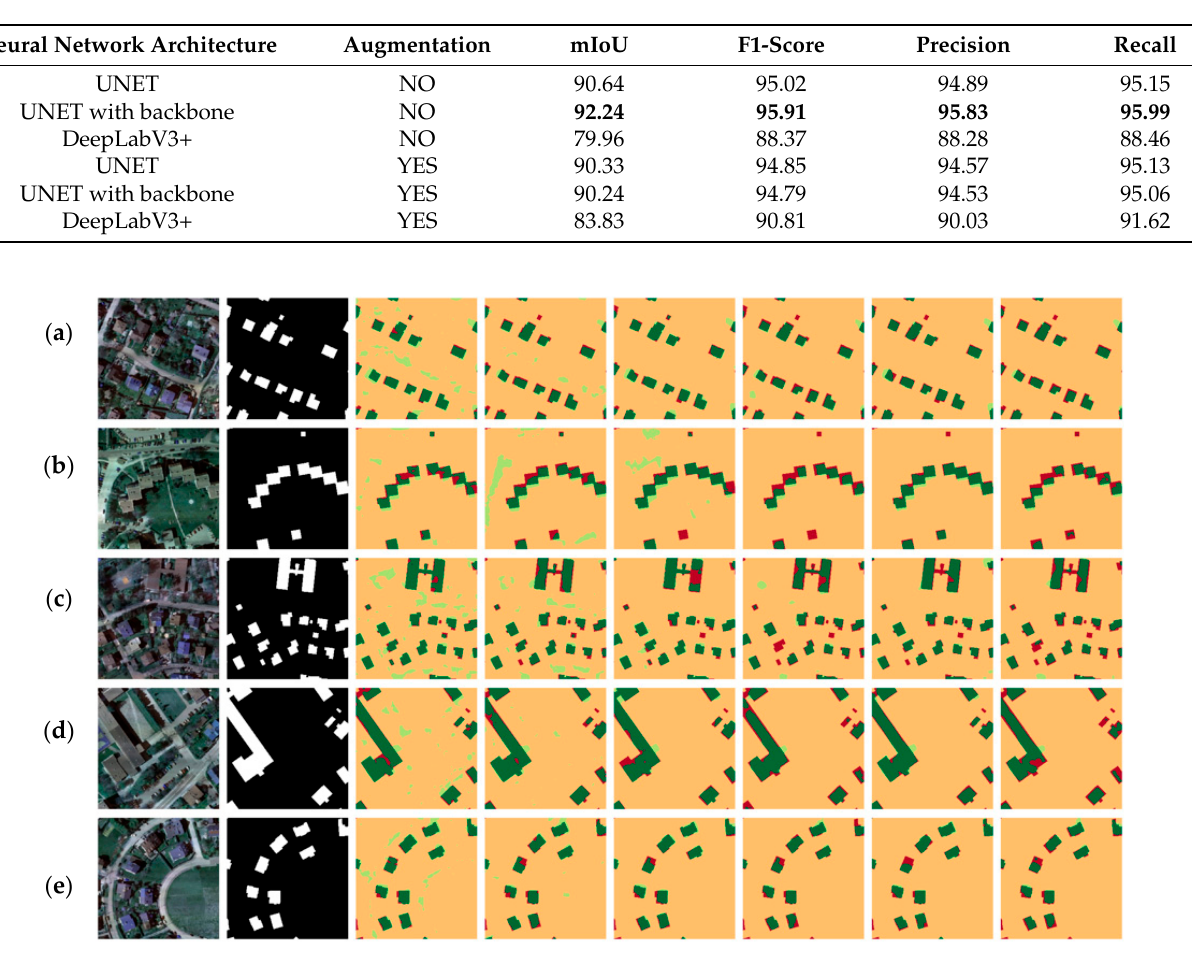
Table 3. Results for 0.5 m dataset [%].